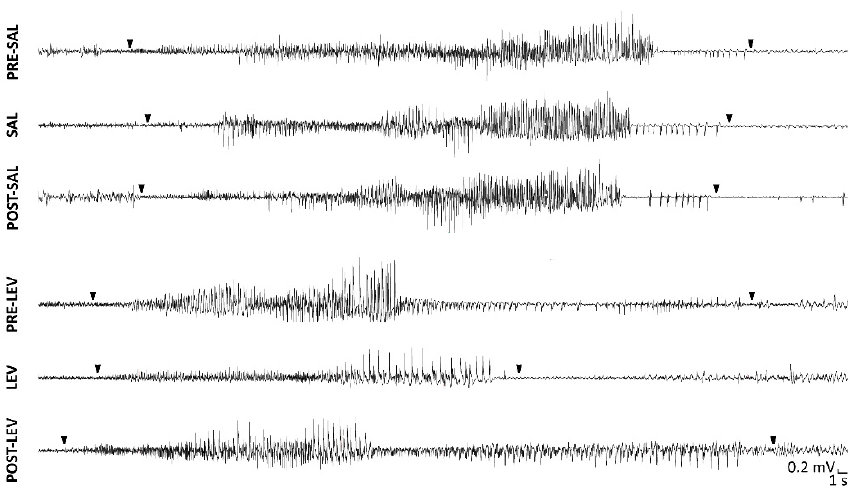
Figure 1. Spontaneous recurrent seizures (SRSs) after induction of status epilepticus in epileptic rats treated with levetiracetam (LEV) or saline. SRSs were recorded in epileptic rats during the treatment with LEV or saline, but also 1 week before and 1 week after LEV or saline administration by subcutaneous osmotic minipumps. Note that SRSs appeared in incomplete responders to LEV. Arrowheads point to onset and termination of SRSs. PRE-, before osmotic minipump implantation; POST-, after minipump implantation; SAL, saline.